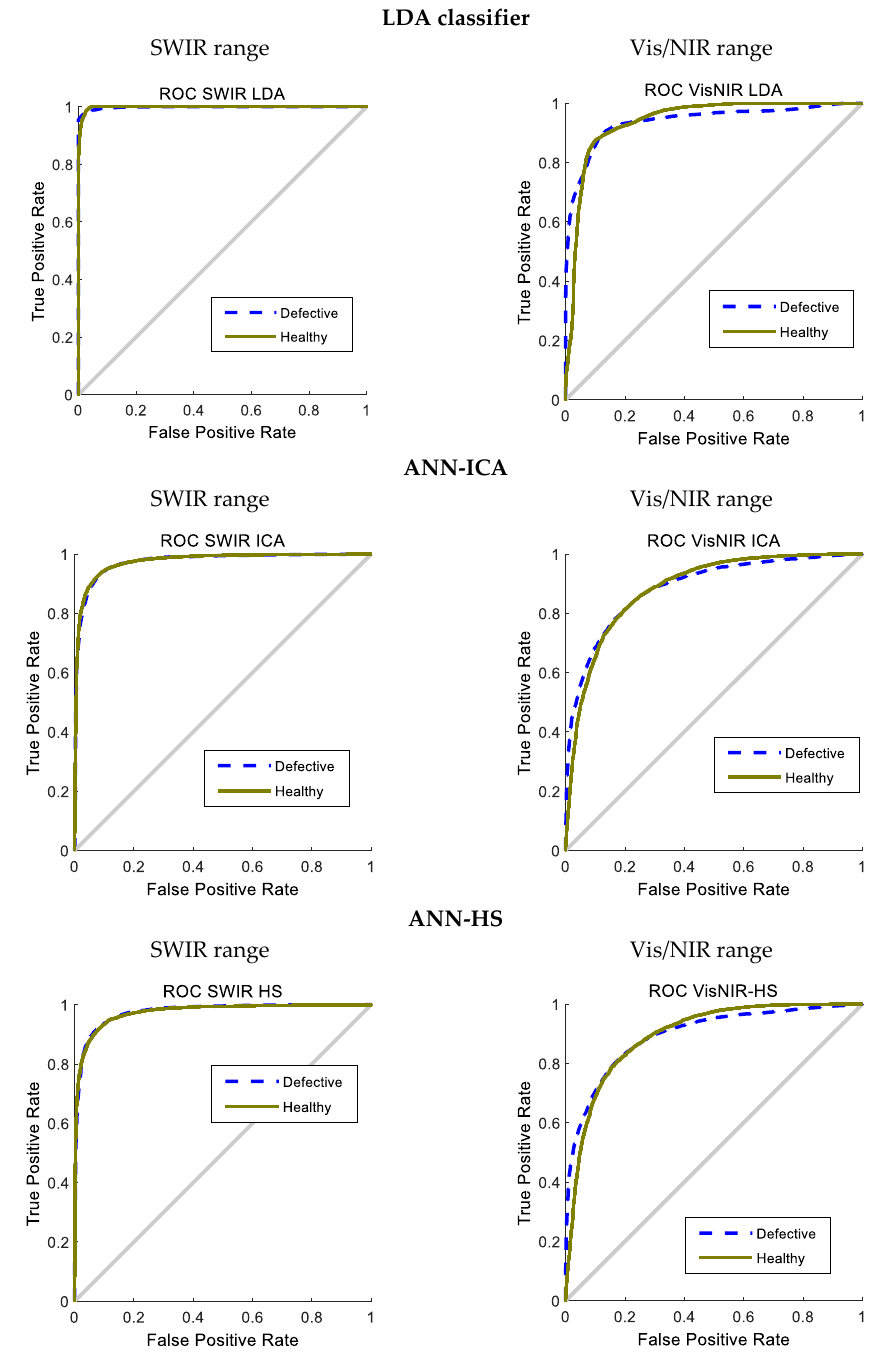
Figure 9. ROC curves of the four basic classifiers to classify potatoes in 200 iterations, using SWIR and Vis/NIR spectral ranges.